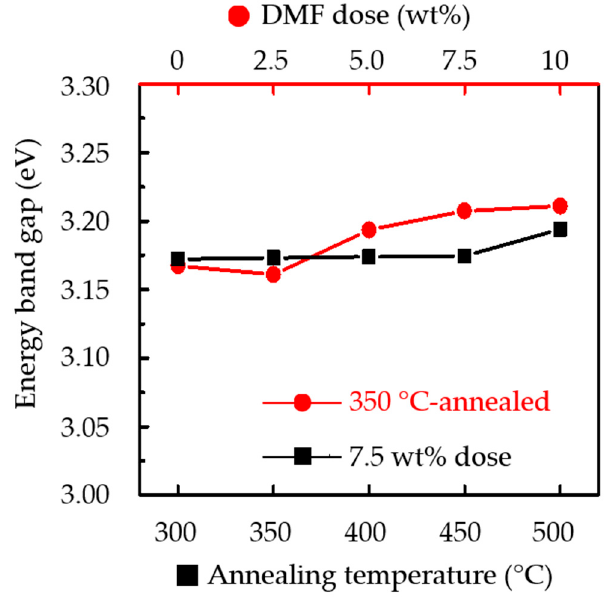
Figure 6. The variation of Eg for the 350 °C-annealed and 7.5 wt%-injected TiO 2 films prepared at various DMF doses and different annealing temperatures, respectively.